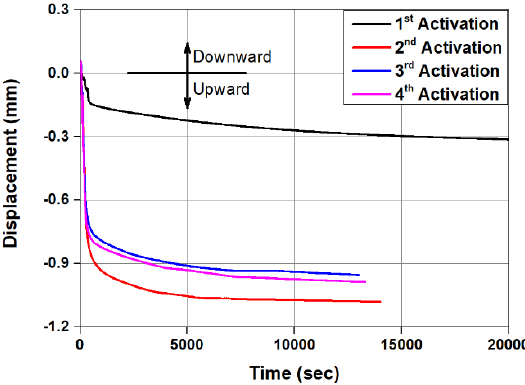
Figure 13. Time – displacement relationship of SL-3R according to number of activations. Figure 13. Time–displacement relationship of SL-3R according to number of activations.